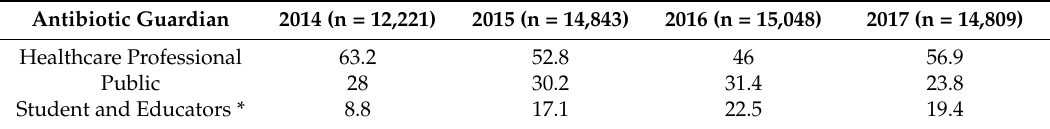
Table 2. Percentage of AG pledges by pledge group from 2014–2017 (n = 56,921).